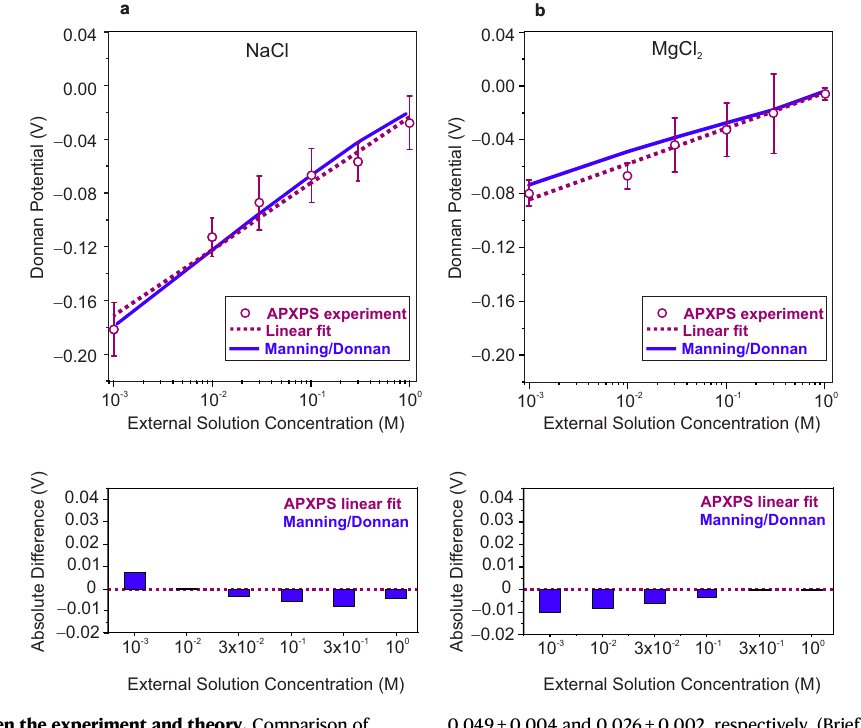
0.049±0.004 and 0.026±0.002, respectively. (Brief discussion and further ana- lysis of experimental uncertainties and statistical signi fi cance are provided in Supplementary Note 7). Details on Donnan potential calculations using the Man- ning/Donnan models are given in Supplementary Note 8. The absolute difference between the linear fi t of the experimental data and predictions from the analytical model is provided to better capture the comparison between theory and experi- ment for each electrolyte